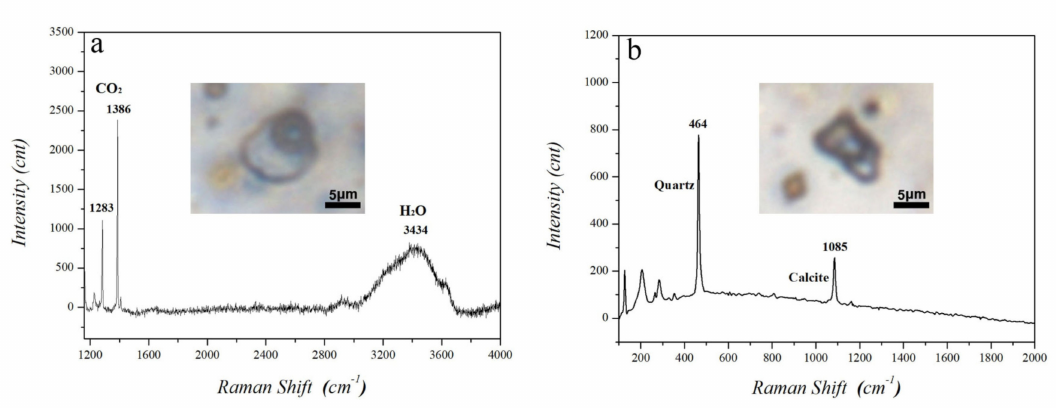
Figure 8. Raman spectra of B1-type fluid inclusion ( a ), and D-type fluid inclusion fluid inclusions at the Linglong gold deposit ( b